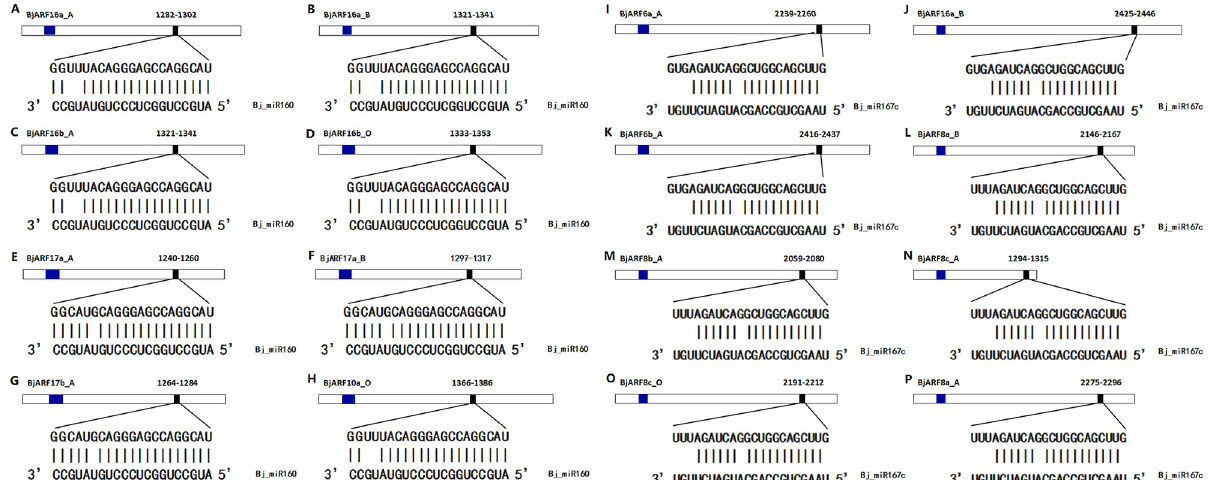
Fig 6. miR160/167c -mediated post-transcriptional regulation of BjARFs . (A-H). Prediction of the BjARFs regulated by Bj-miR160 ; (I-P). Prediction of the BjARFs regulated by Bj-miR167c . miRNA target sites (Black) with the nucleotide positions of BjARF transcripts are shown, and the Auxin_resp domain (Blue) with the nucleotide positions of BjARF transcripts are shown. The RNA sequences of each complementary site from 5 0 to 3 0 and the predicted miRNA sequence from 3 0 to 5 0 are indicated in the expanded